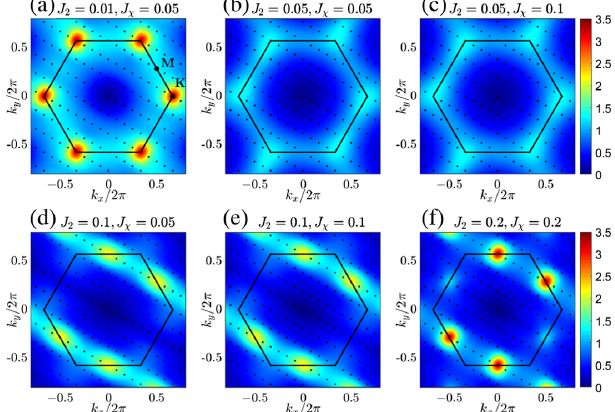
FIG. 7. The spin structure factor S ð k Þ obtained on an N ¼ 36 × 6 cylinder using correlations from middle N 0 ¼ 12 × 6 sites. (a) SC1 phase at J 2 ¼ 0 . 01 . (b),(c) Isotropic d þ id -wave TSC phase at J 2 ¼ 0 . 05 with near-isotropic structure. (d),(e) Nematic TSC phase at J 2 ¼ 0 . 1 . (f) SC0 state at J 2 ¼ 0 . 2 . The first Brillouin zone is indicated by the solid line with the M and K points marked, and the black dots represent the allowed discrete momenta for the finite system with 12 × 6 sites. The results are obtained with M ¼ 10 000 . The doping level is δ ¼ 1 = 12